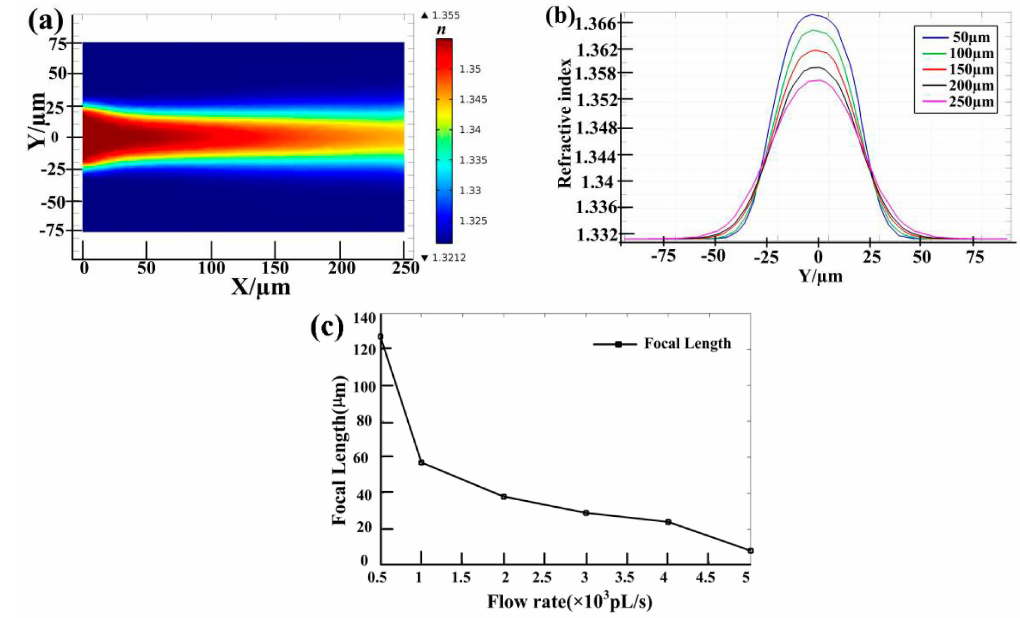
Figure 5. ( a ) The refractive index profile in the xoy plane with the flow rate of 4 ˆ 10 3 pL/s; ( b ) The cross-sectional refractive index profiles at five different locations ( x = 50, 100, 150, 200 and 250 µ m) with Q clad = 8 ˆ 10 3 pL/s, Q core = 1 ˆ 10 3 pL/s; ( c ) The focal length of the L-GRIN microlens with different flow rates of